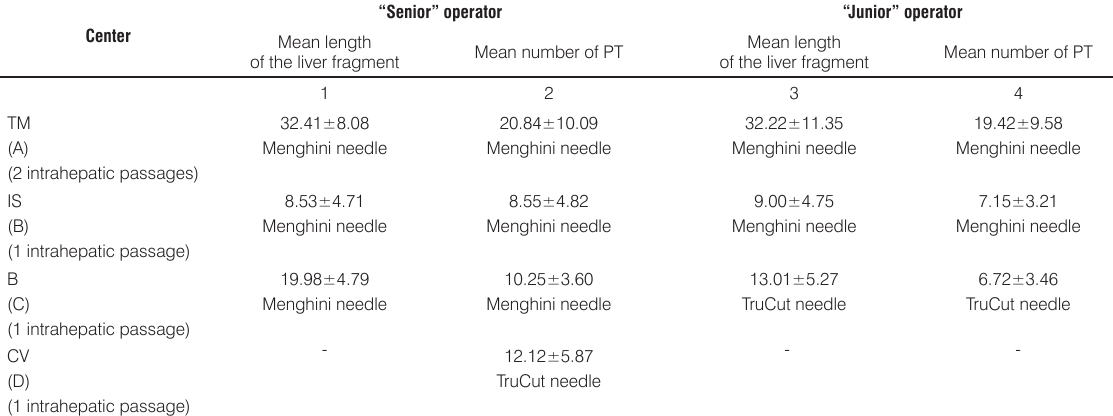
Table 2. Mean fragment length and mean number of PT in different centers, correlated with the operator’s experience and the type of needle used for LB.